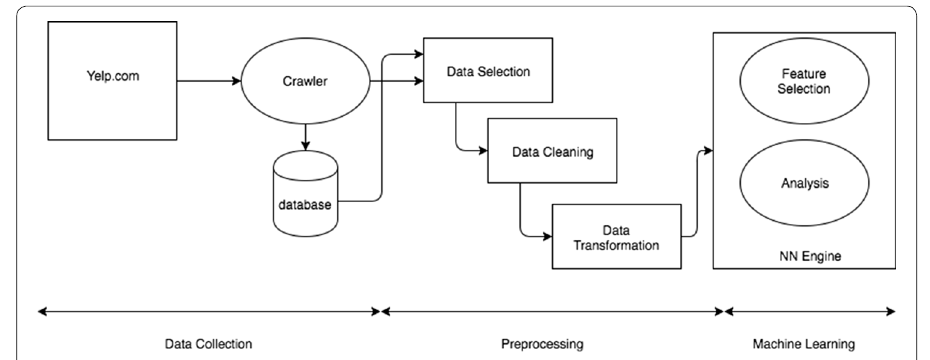
Fig. 1 System architecture for our